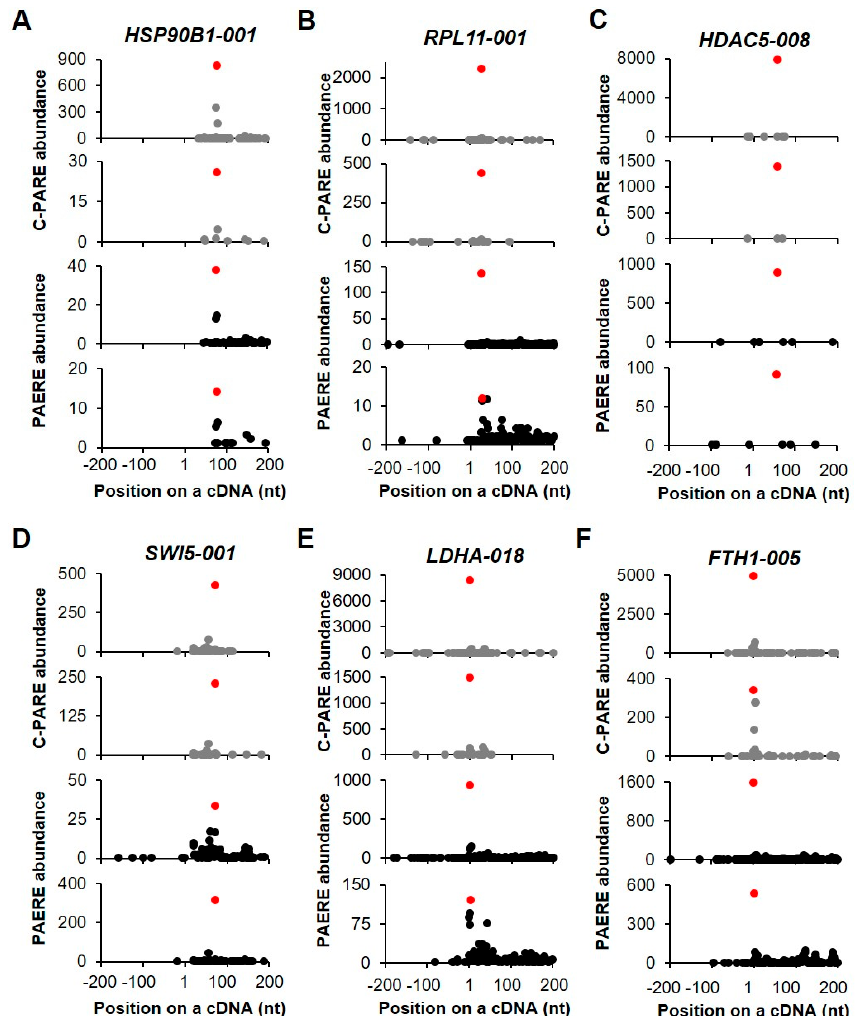
Figure 9. Selected examples of decapped transcripts. ( A – F ) The plots show the C-PARE sequence abundance and PARE sequence abundance along the cDNA positions in a +/ − 200-nt window from two biological replicates. Red dots indicate the most abundant C-PARE and PARE sequences at the same positions.